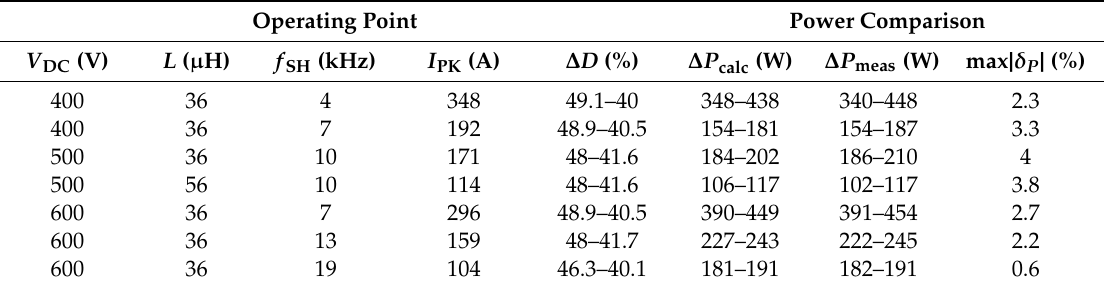
Figure 8. Power losses in the half-bridge: transistors (red), diodes (blue) and sum of power losses in the module (black) obtained from calculations in MATLAB and experiments (stars) shown for two cases: V DC = 400 V, f SH = 4 kHz (a) and V DC = 600 V, f SH = 19 kHz (b). Table 1. Results for all measurement series carried out for different operating points.